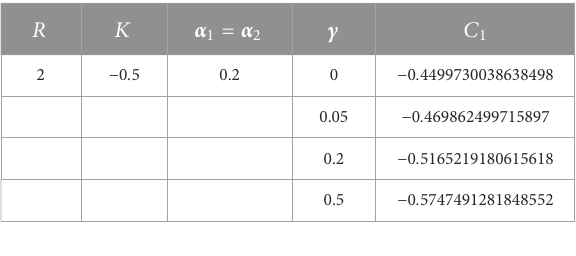
TABLE 2 Optimal values of auxiliary constant C parameters (plane Couette – Poiseuille fl ow).